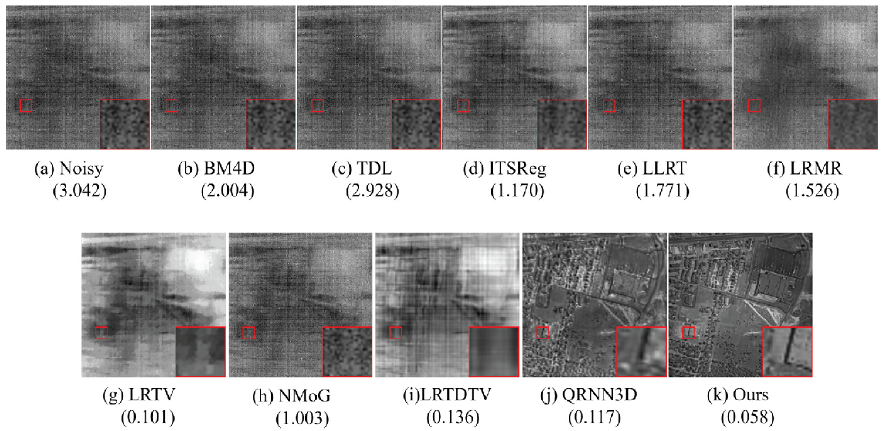
Figure 8. The denoised results on band 106 of the Urban dataset for all the competing